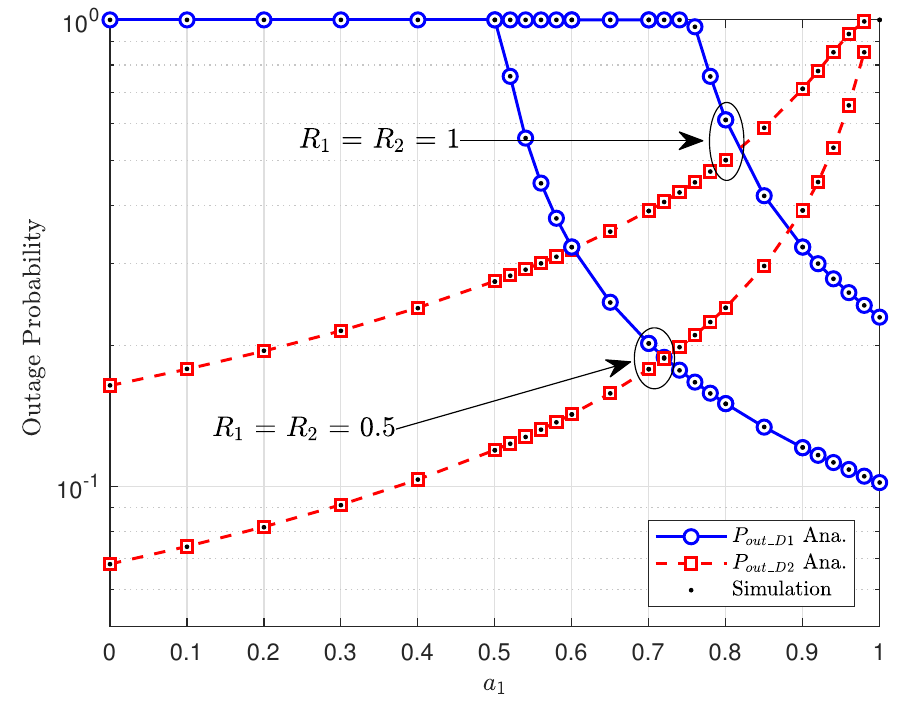
Figure 6. Impact of power allocation factors on the performance of the NOMA-based V2X